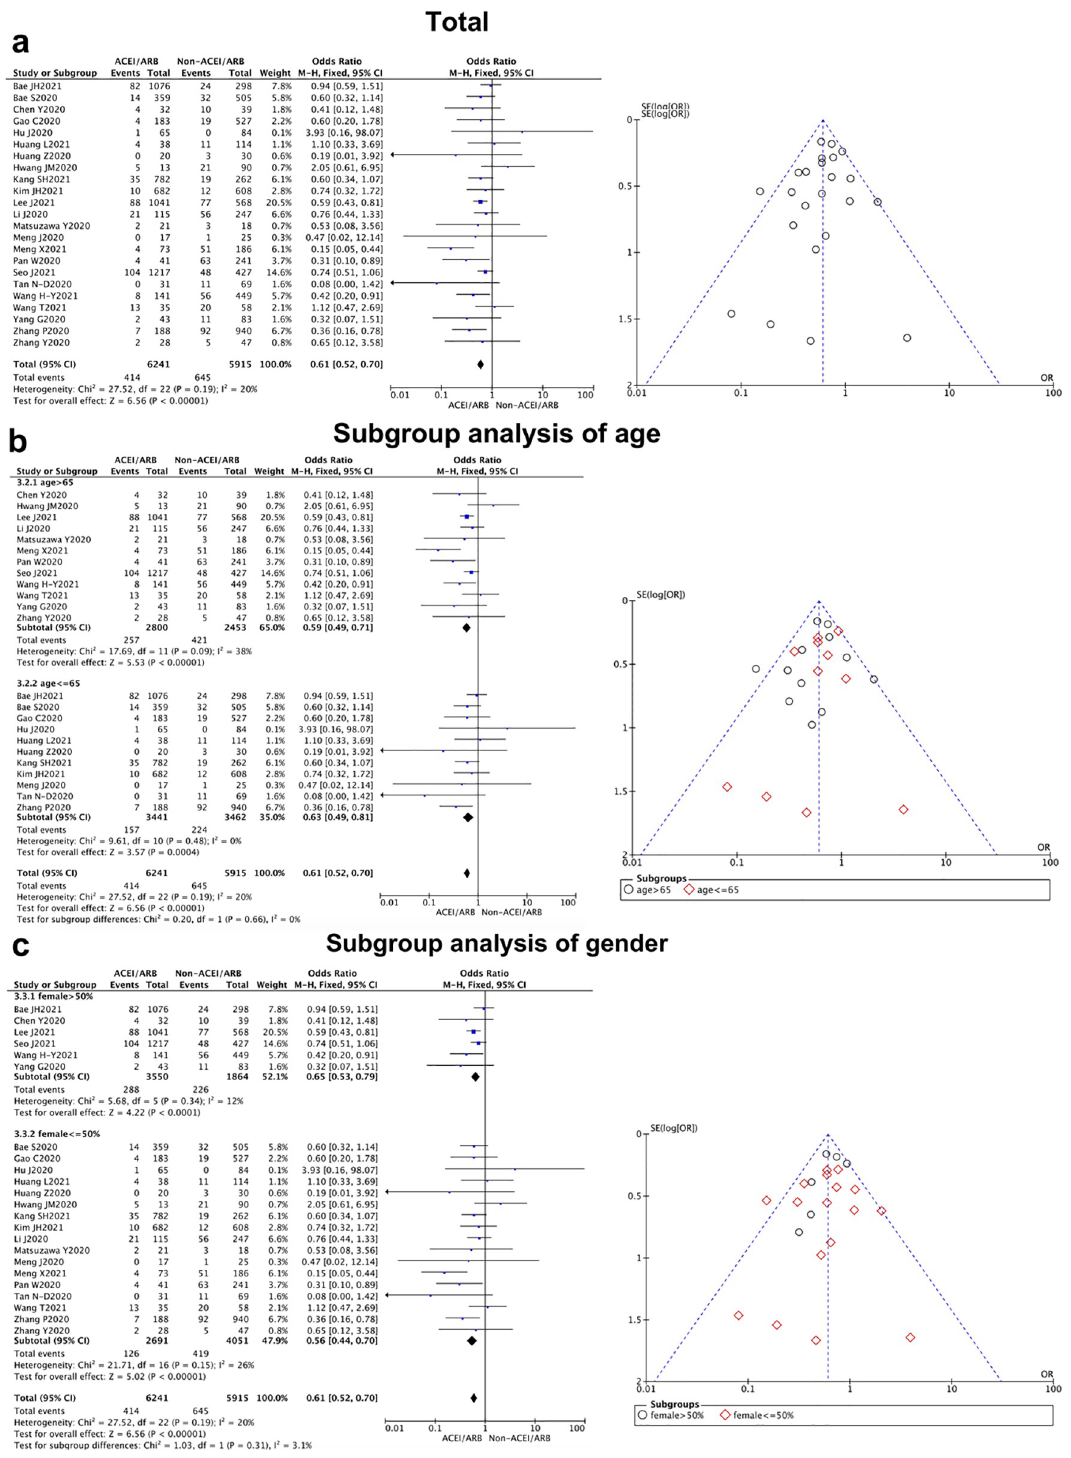
Fig 4. Mortality of East-Asian Covid-19 patients treated with ACEI/ARB vs. untreated subjects. All-cause mortality data of OR and 95% CI from 23 studies were pooled in this meta-analysis and the result of meta-analysis was described as a forest plot. (a) The whole group analysis; (b) The subgroup analysis of age; (c) The subgroup analysis of gender.